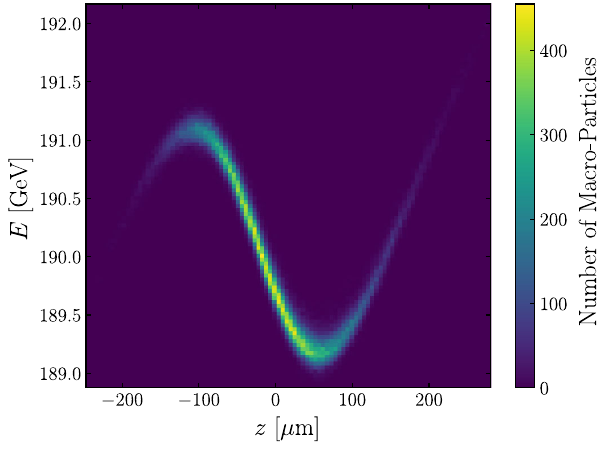
FIG. 4. Energy E vs longitudinal position z of the IP beam distribution. This beam was tracked through a perfect beamline.